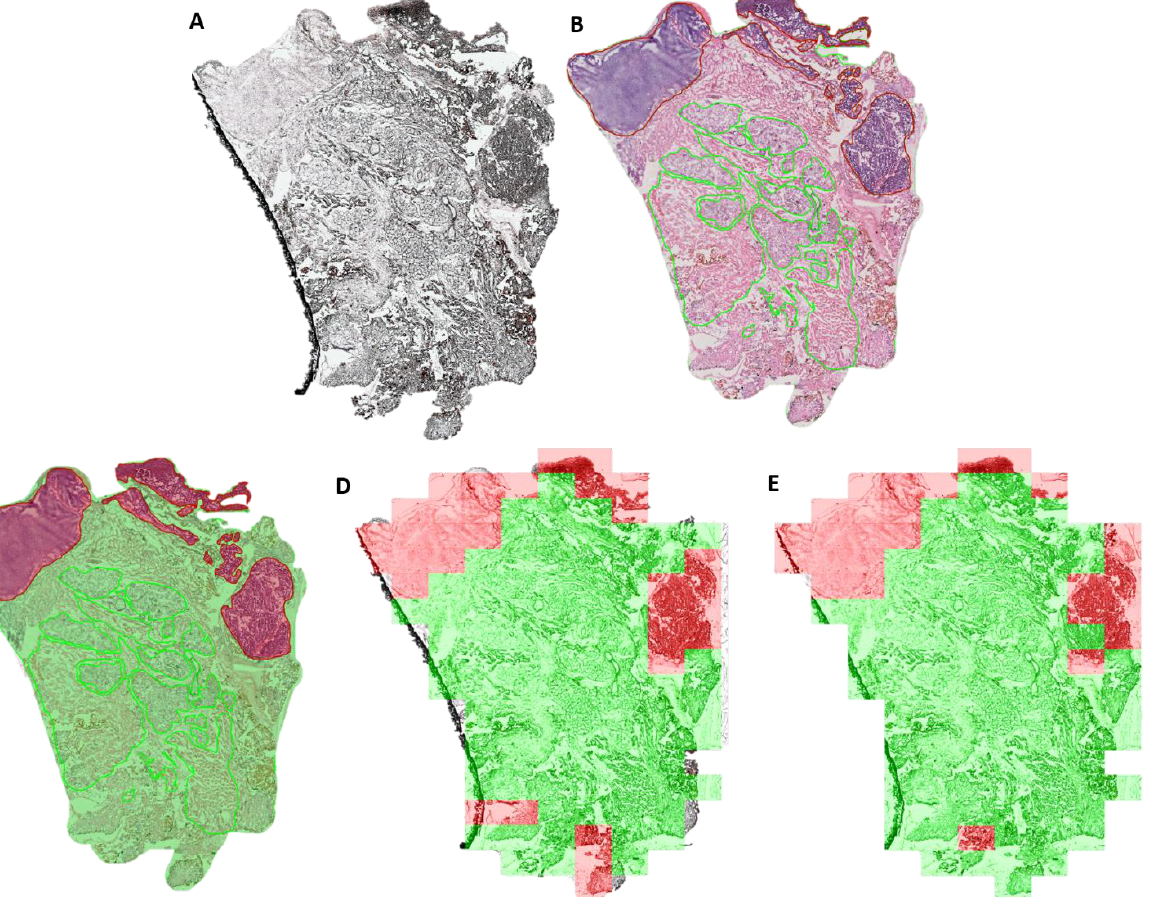
Figure 3. Visualization of the tumor classification results of 3.1.3 and 3.1.4 on an exemplary tissue section. ( A ) unstained tissue section. ( B ) H&E stained tissue section. ( C ) Manual histopathological annotations. ( D ) Tumor classification using a fine-tuned ResNet architecture on false color images. ( E ) Tumor classifications results using a 3D CNN on the full hyperspectral data cubes. Green: healthy tissue. Red: Tumor tissue.